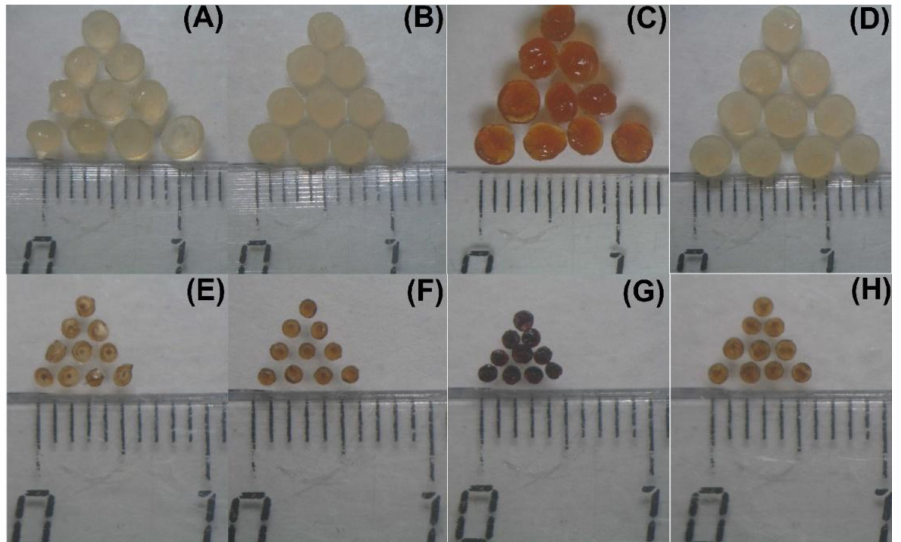
Figure 1. Photographs of wet ( A – D ) and dried ( E – H ) CaPG, ZnPG, FePG, and AlPG beads. The wet ZnPG beads had the smallest diameter and surface area and were of the highest density among wet gel beads (Table 1). The surface area of the wet ZnPG beads was 15–21% lower than the CaPG, FePG, and AlPG beads. The density of the wet ZnPG beads was 24, 36, and 48% higher than CaPG, FePG, and AlPG beads, respectively. The ZnPG and AlPG beads were spherical, as evidenced by the sphericity factor (SR, Table 1), and their aspect ratio was close to 1.0. The CaPG and FePG beads were less spherical. The water content, measured by drying the wet beads to a constant weight at 25 ◦ C, was 94.7–95.7%. The dried, similar to the wet, ZnPG beads had the smallest dimensions and the highest density among the dried gel beads (Table 1). The density of the dried CaPG beads was 47% lower than the ZnPG beads. Table 1. Characterization of gel beads.